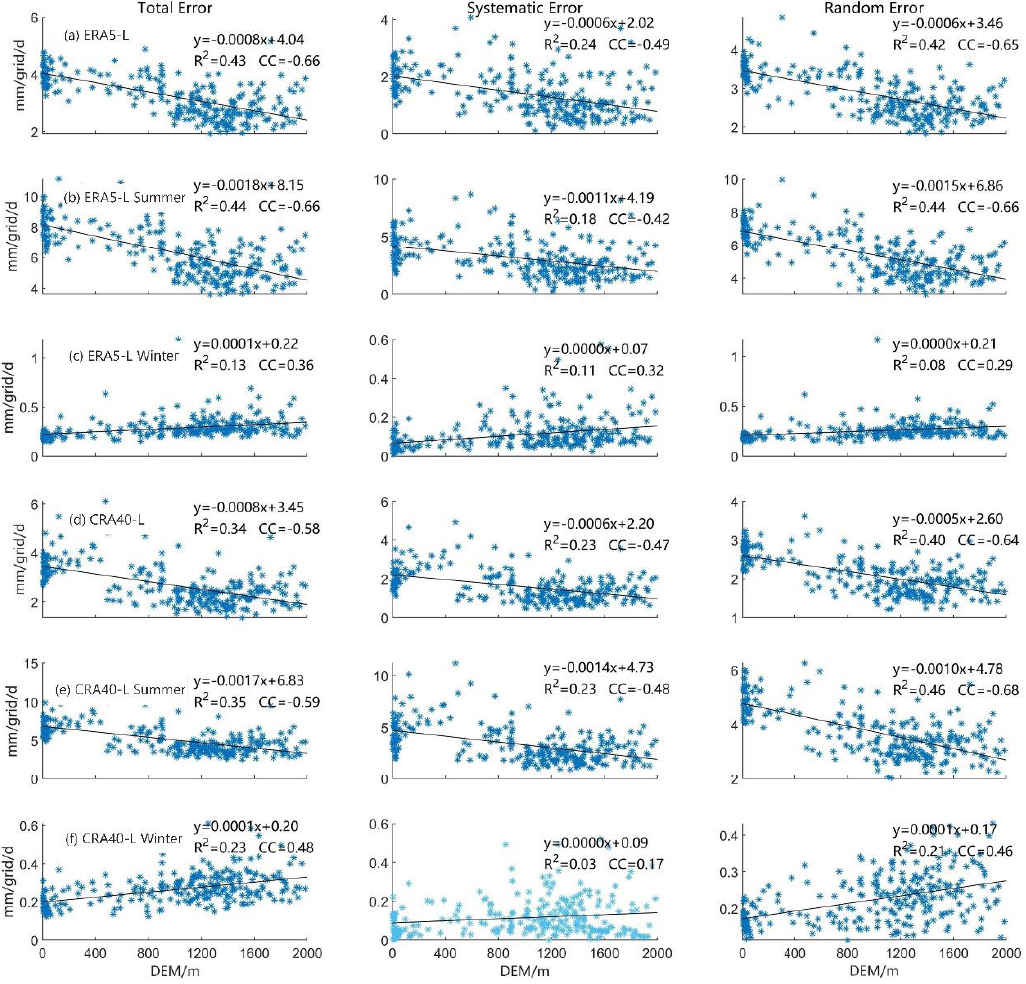
Figure 7. ( a – f ) Correlation of the elevation with systematic and random error components. Overall, only the systematic error of CRA40-Land in winter failed to pass the hypothesis test at α = 0.001 but passed the hypothesis test at α = 0.01. The elevation had a significant effect on the error, with the two demonstrating a negative correlation in summer and a positive correlation in winter. Significant seasonal variations were observed due to enhanced precipitation in summer, and above all, the annual trend observed was the same as that in summer. However, the concentration and dispersion degrees throughout the year and in summer were different. In particular, CRA40-Land had a higher concentration